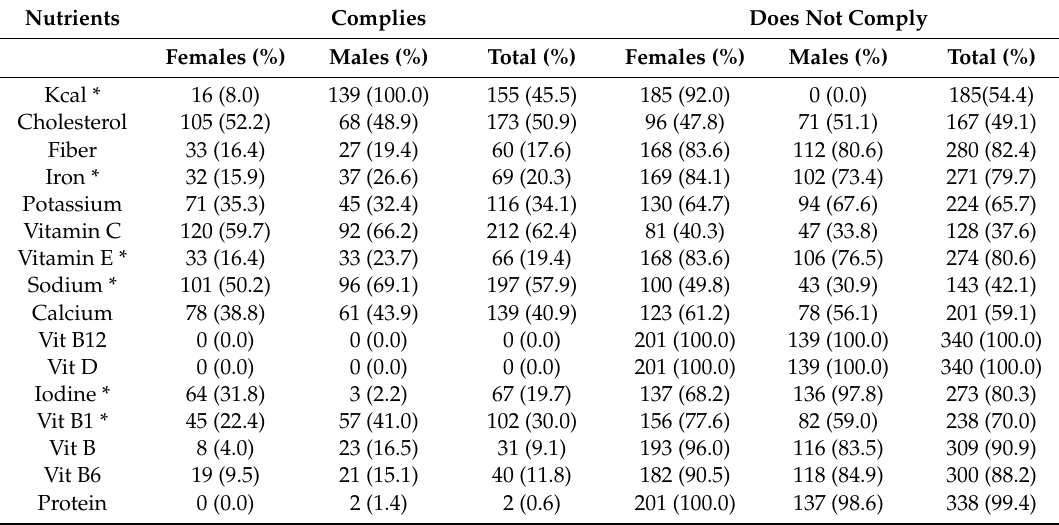
Table 3. Di ff erences in compliance with recommended daily intakes as a function of